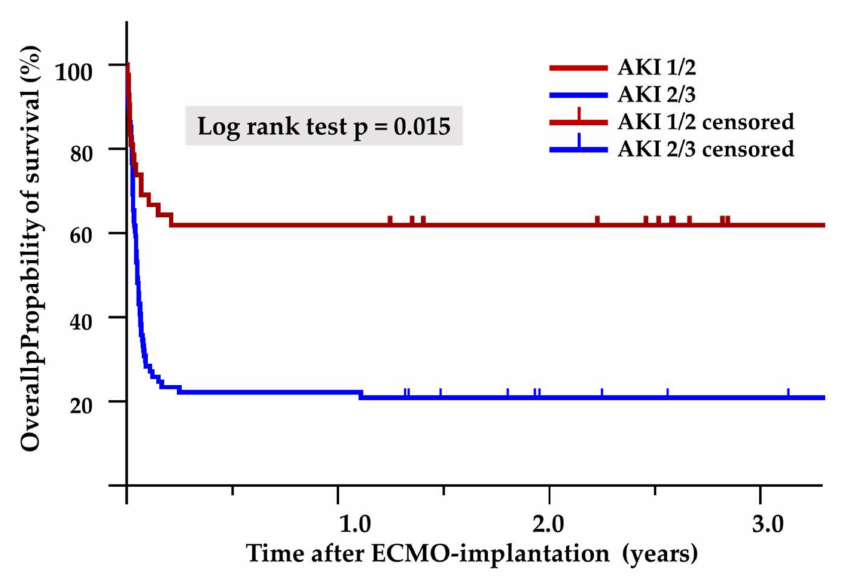
Figure 2. The Kaplan–Meier survival curve.